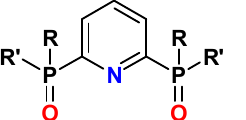
The distribution ratios of americium upon extraction from 1–2 M HNO 3 with a so- lution of 0.001 M Ph 2 PyDPO in nitrobenzene reached values of 30–40 while exhibiting moderate selectivity with respect to americium (SF(Am/Eu) = 7.3–8.5) and relatively high selectivity for N,O-donor ligand selectivity with respect to curium (SF(Am/Cm) = 3.0–3.5). The values of the solvate numbers Am(III), Cm(III), and Eu(III) calculated by the slope analysis method were close to 2, i.e., a solvate with the ratio M:L = 1:2 was formed in the organic phase. The extraction ability of tBuPhPyDPO was much lower: the distribution ratios of Am during extraction from 1–2 M HNO 3 with a solution of 0.001 M tBu- PhPyDPO in nitrobenzene did not exceed 0.1. The authors explained this difference in the extraction ability of the two ligands on the basis of the presence in the case of tBu- PhPyDPO of large steric hindrances created by the bulky tBu substituent. NMR titration in acetonitrile-d3 showed that all possible centers of ligand complex- ation, namely, the N atoms of the pyridine ring and the O atoms of the phosphine oxide groups, participated in the formation of a complex with a metal ion. Pyridine-di-phosphonates were discussed as chelators for trivalent f-elements. The separation factor SF Am/Eu for the best extractant reached values of up to 10 [174]. Three representatives of ligands were synthesized, having phenyl substituents at the phosphorus atom and various N-heterocyclic cores—pyridine-2,6-diphosphine oxide, 2,2′-bipyridyl-6,6′-diphosphine